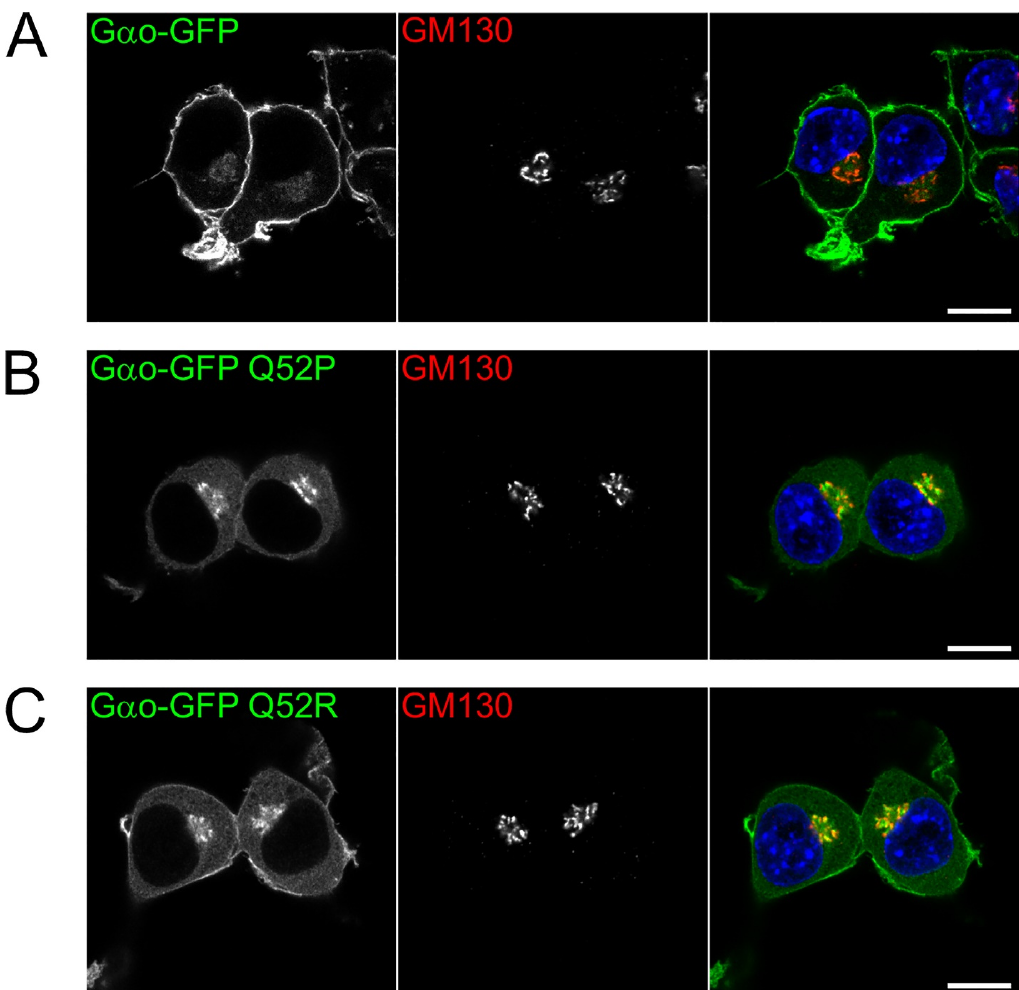
Figure 4. Pediatric encephalopathy mutations in Gln52 of G α o strongly impair its plasma membrane (PM) localization. Representative confocal images of N2a cells expressing G α o-GFP wild-type ( A ) and its Q52P ( B ) and Q52R ( C ) mutants. Cells were immunostained against GM130 as a Golgi marker; DAPI stained the nuclei in blue. Note that both Gln52 mutants showed a strong reduction in PM association and seemed to accumulate at the Golgi region and cytosol instead. Scale bars, 10 µ